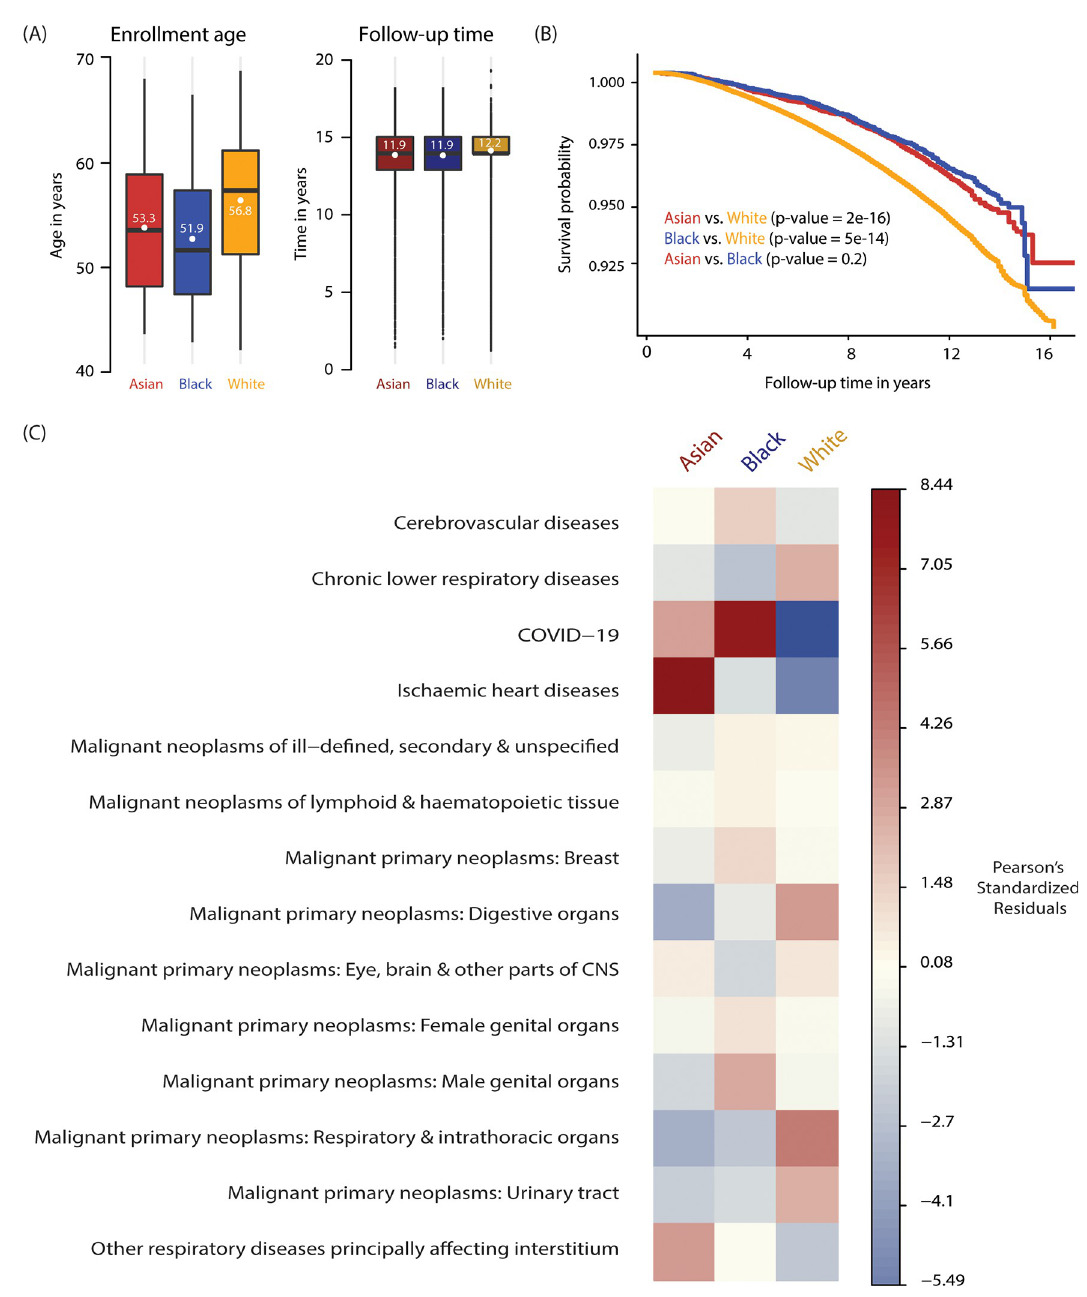
Fig 2. Ethnicity and mortality in the UKB. (A) Study enrollment age and follow-up time distributions for Asian (red), Black (blue), and White (yellow) ethnic groups. (B) Kaplan-Meier curves showing survival probabilities over time for Asian, Black and White ethnic groups. P-values for ethnic group pairwise log-rank test of survival curves are shown. (C) Associations between ethnicity and specific mortality causes as measured by Pearson’s standardized residuals from Chi-square test of independence. (HR = 0.743 [0.571,0.967], p = 0.027; HR = 0.479 [0.345,0.665], p < 0.0001; HR = Asian Black White 0.694 [0.559,0.863], p < 0.0001) (Fig 3A). Being female was associated with reduced mortality risk by more than 36% compared to males in Asian and Black group but not in Whites. Several blood and urine biomarkers showed significant effect on overall mortality of Asians including